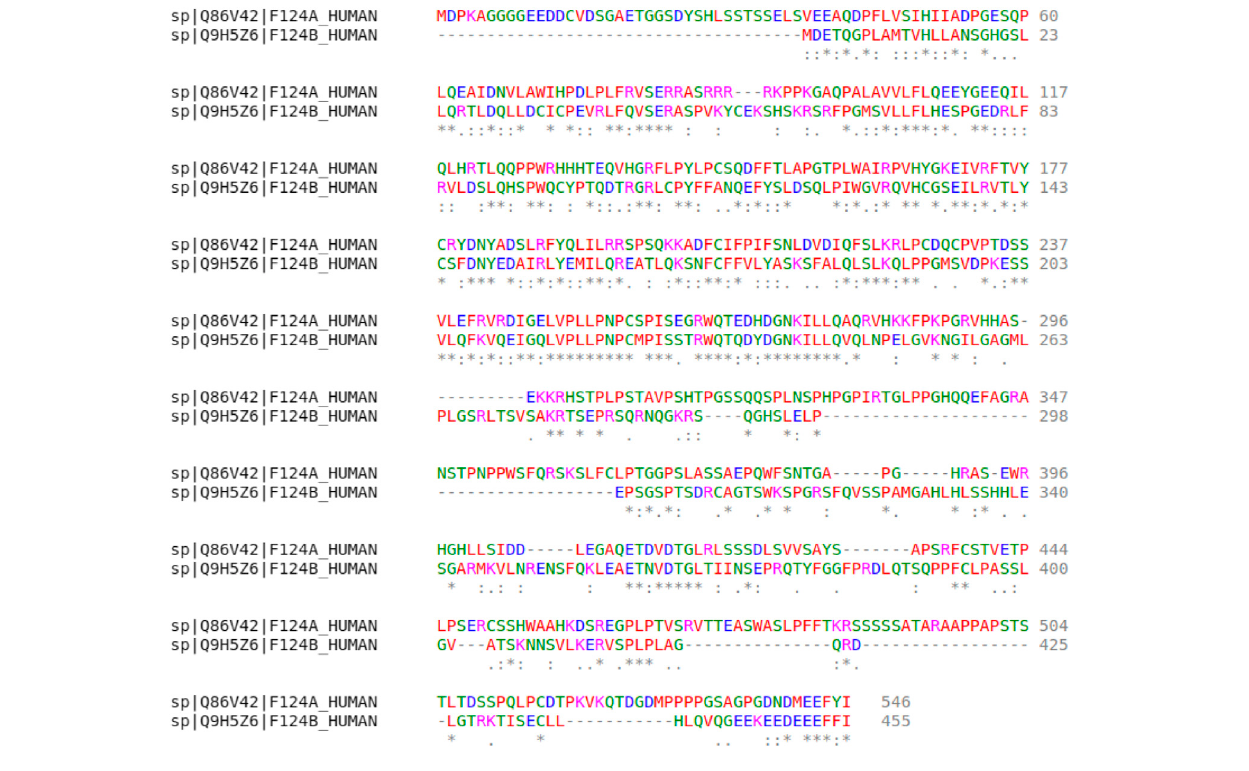
FIGURE 7 | Alignment of FAM124A (present) and FAM124B identi fi ed via manual